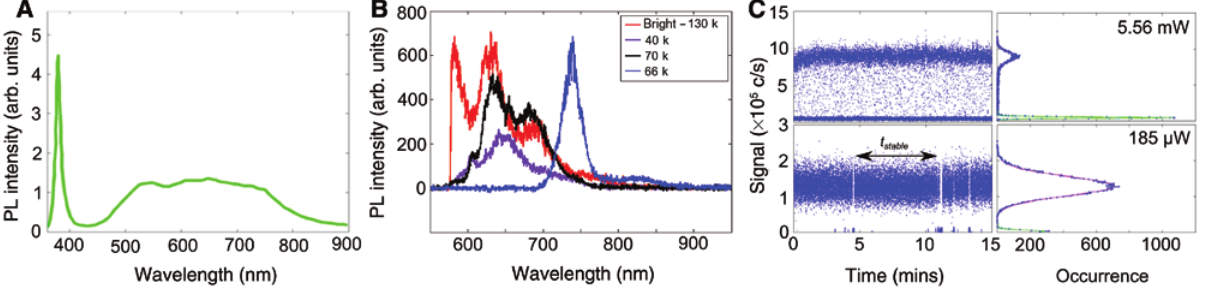
Figure 2: PL spectra of the ZnO sample annealed at 700 ° C. (A) Bulk ensemble measurement with an excitation from a 325 nm HeCd laser (spot size≈0.2 mm; see Section 2.3). (B) Single